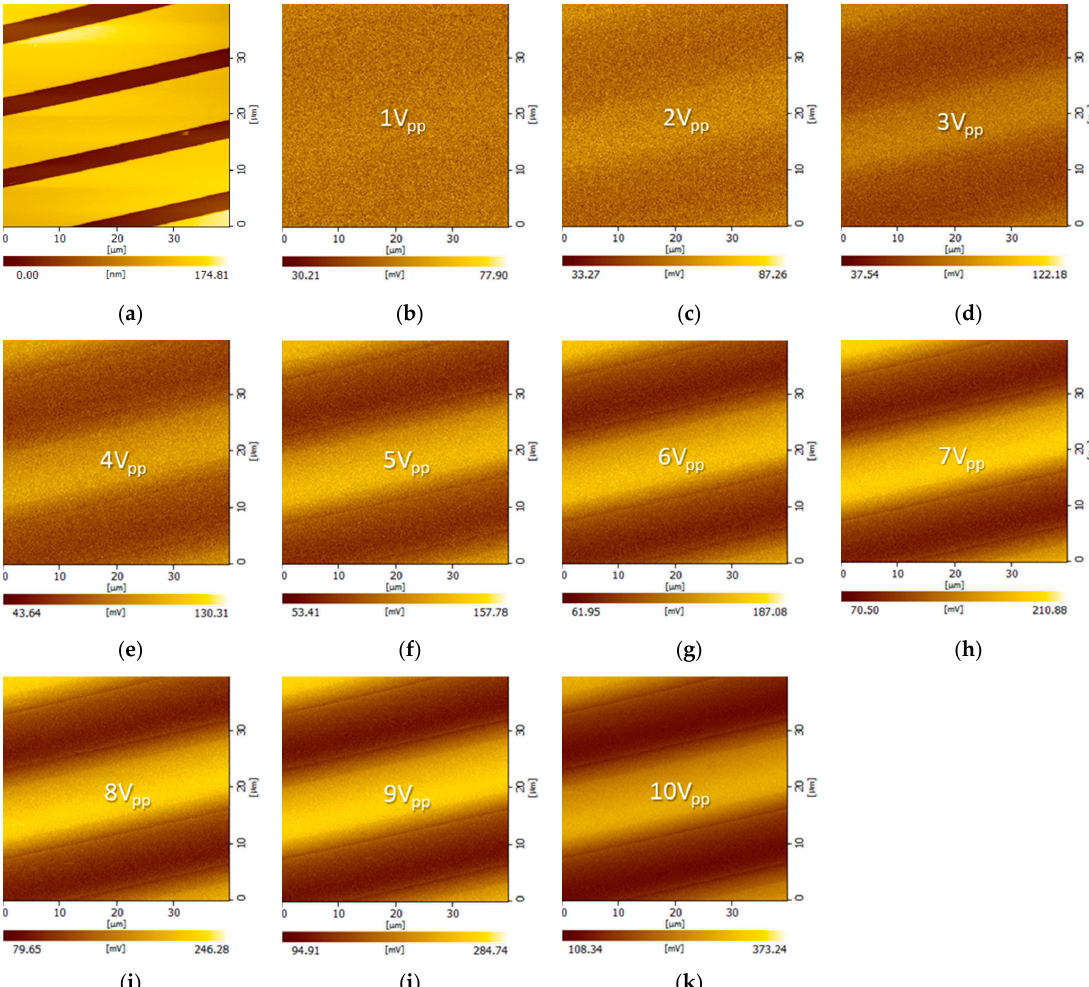
Figure 6. ToGoFET images of interdigitated electrodes covered with 500-nm-thick oxide: ( a ) the topographic image; ( b – k ) electrical images were obtained at various voltages with a driving frequency 100 kHz.